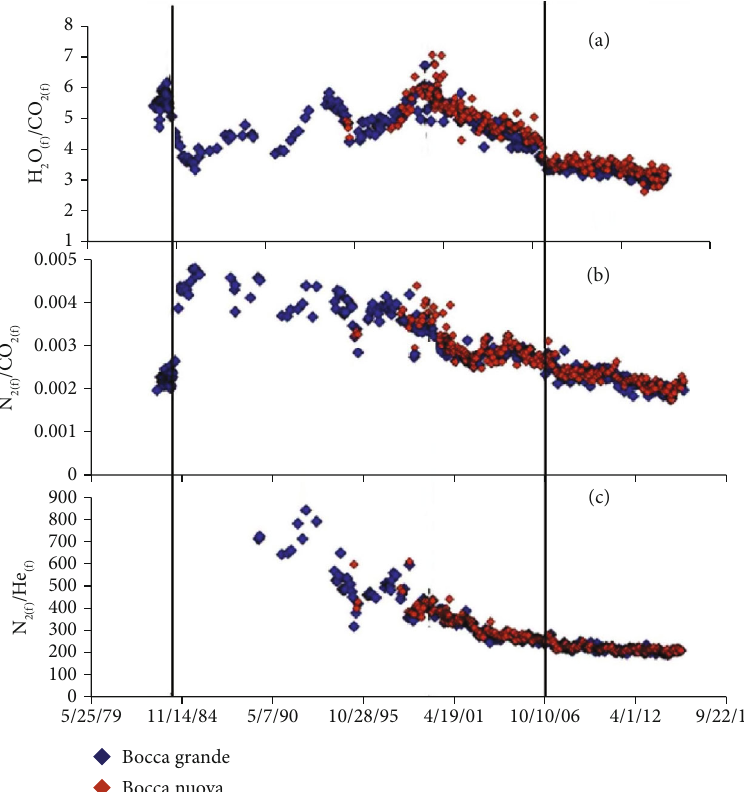
Figure 4: Gas ratios measured at Solfatara Bocca Grande and Bocca Nuova fumaroles: (a) H from Troise et al.